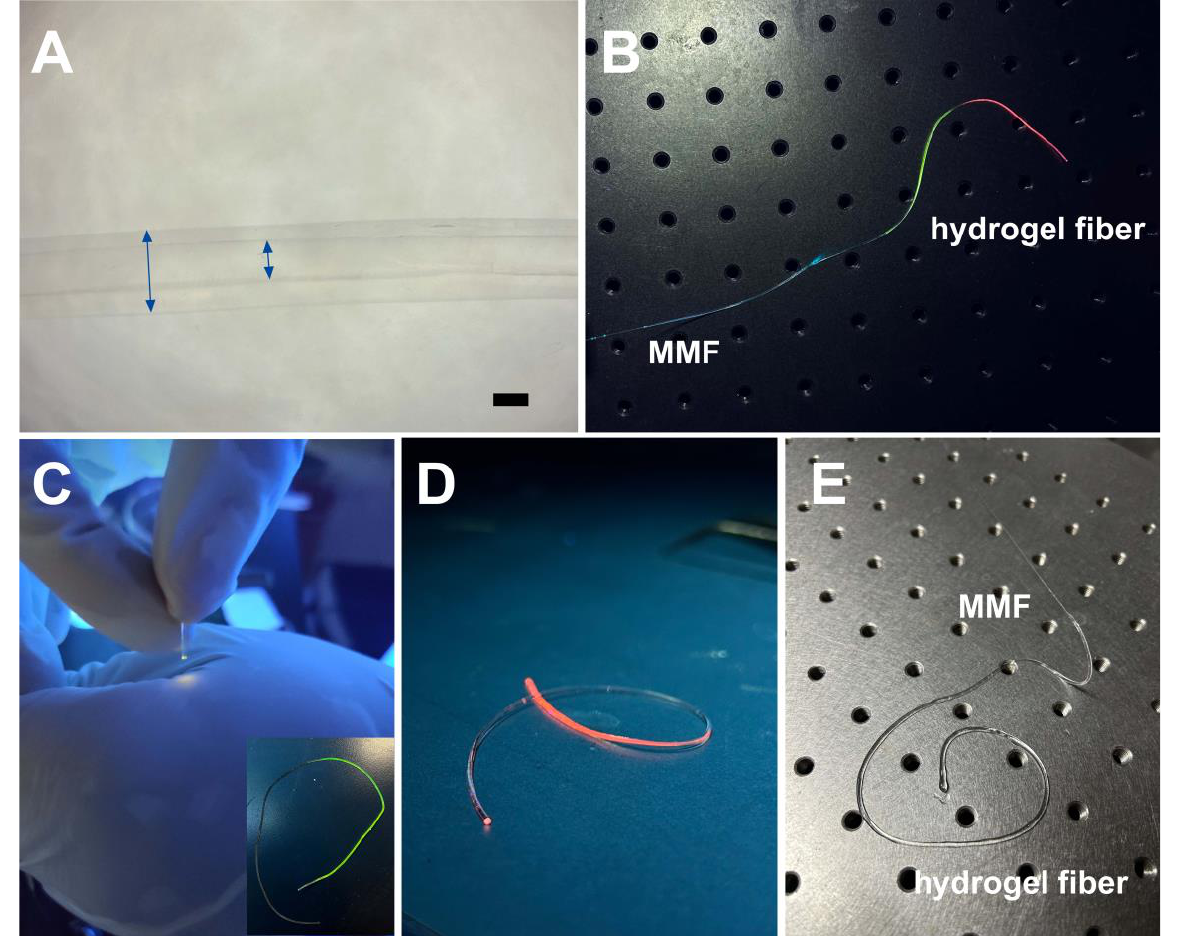
Figure 2. The photographs of the fluorescent hydrogel fiber. ( A ) The optical microscope photograph of the hydrogel fiber. Scale bar = 0.5 mm. ( B ) The fluorescence photograph of fluorescent hydrogel fiber excited with 490 nm light. ( C , D ) Fluorescence photographs of hydrogel fiber underside UV light (365 nm) illumination. ( E ) Photographs of the fabricated hydrogel fibers.